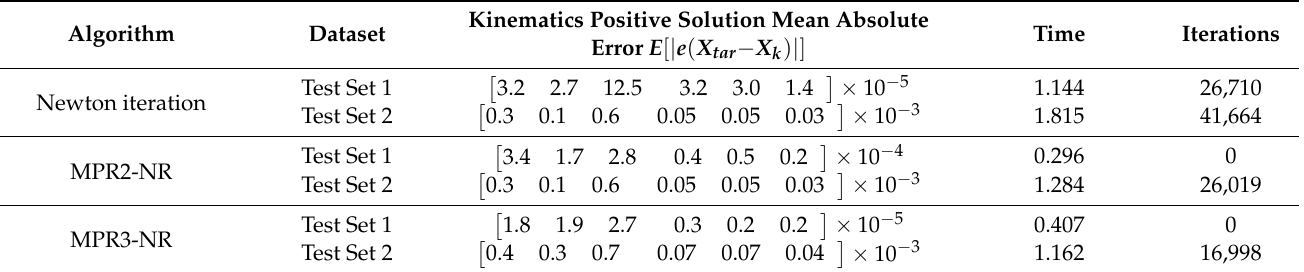
Table 3. Comparison between Newton iteration method and MPR-NR